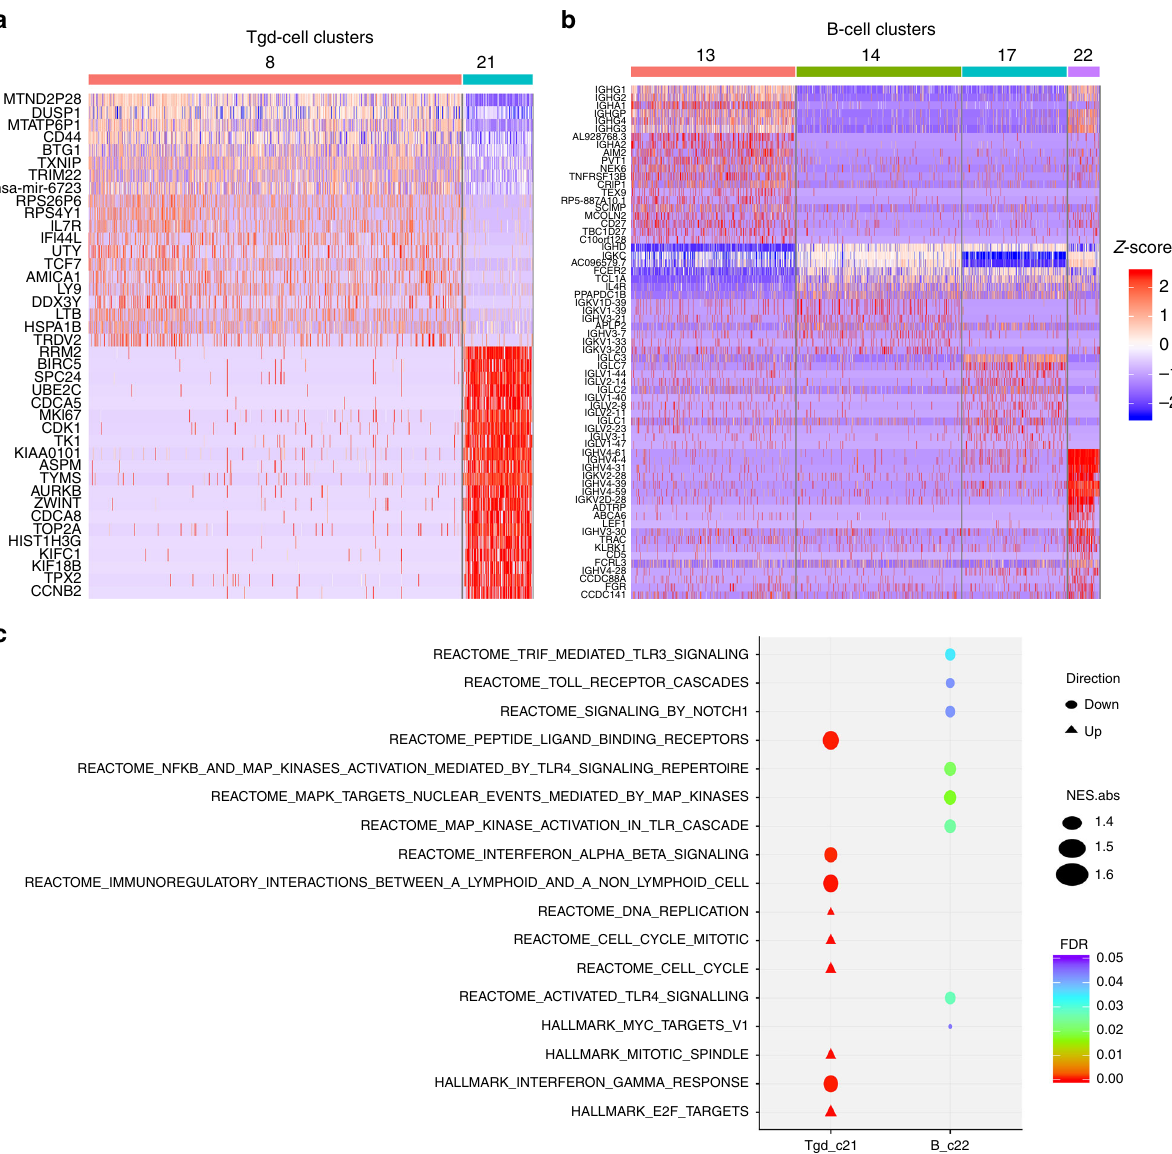
Fig. 3 The analysis of the gammadelta T cells (Tgd) cells and B cells subsets in the melanoma samples. The scRNA-seq dataset - GSE120575 was used in this analysis. a Heatmap of z -scored expression of the top up-regulated genes of the Tgd subpopulations – Tgd_c8 and Tgd_c21. b Heatmap of z -scored expression of the top up-regulated genes of the B-cells subpopulations – B_c13, B_c14, B_c17, and B_c22. c The signi fi cantly altered molecular pathways in the Tgd_c21 and B_c22 immune cell subpopulations whose percentages were associated with ICT